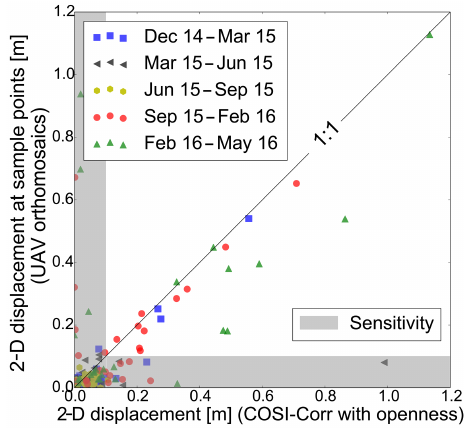
Figure 2. Scatterplot of estimated surface displacements deter- mined by COSI-Corr with openness plotted against the manual ob- servation per epoch pair (Peppa et al.,